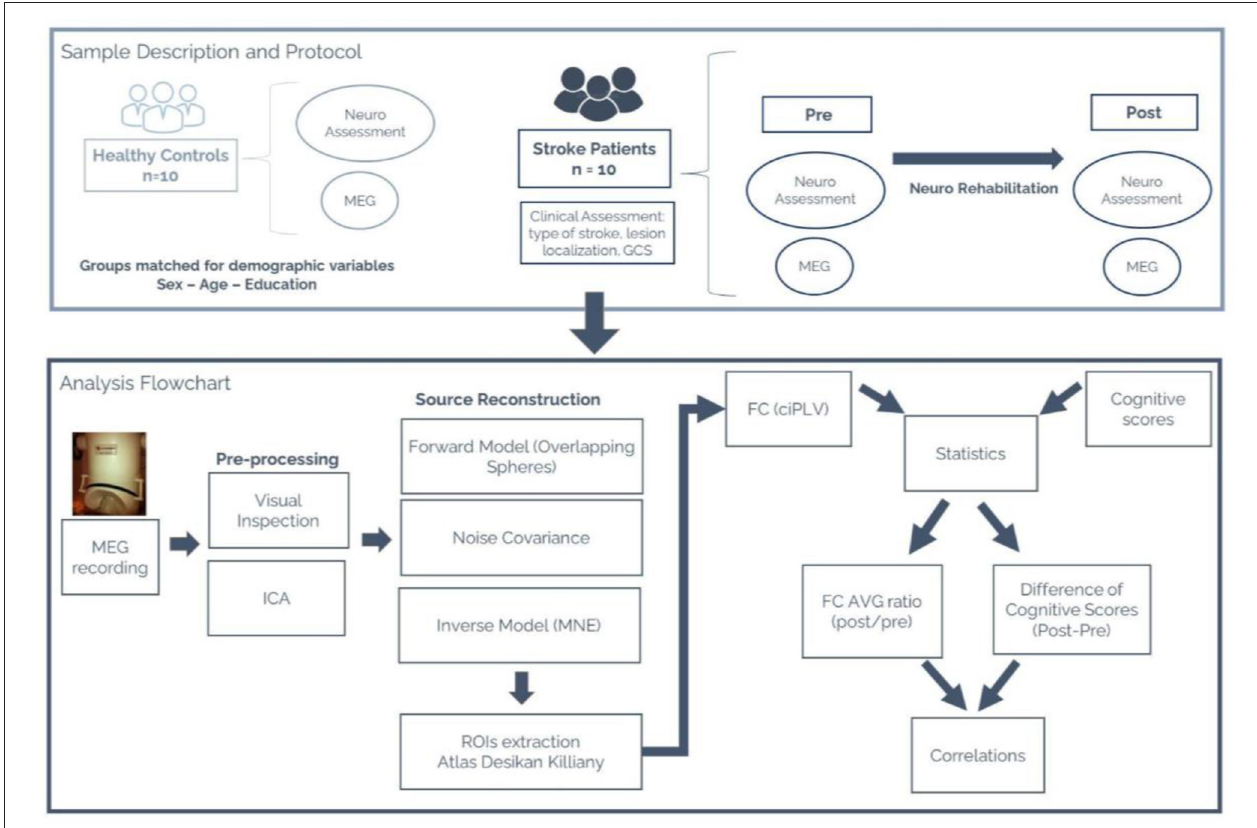
FIGURE 1 | (Top) Sample description (stroke patients and healthy control groups). Description of the protocol followed by each group and the variables collected for this study. (Bottom) MEG Analysis flowchart. Sequential pipeline of the analysis performed on the MEG